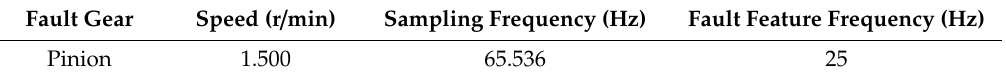
Table 2. The information of the experimental conditions.